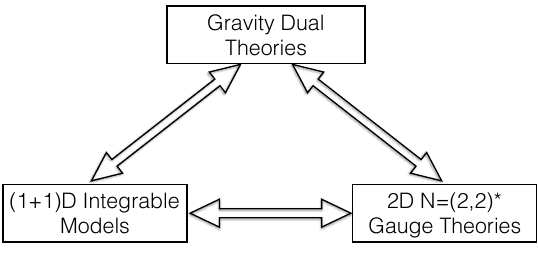
Figure 1 . The triality among di(cid:11)erent